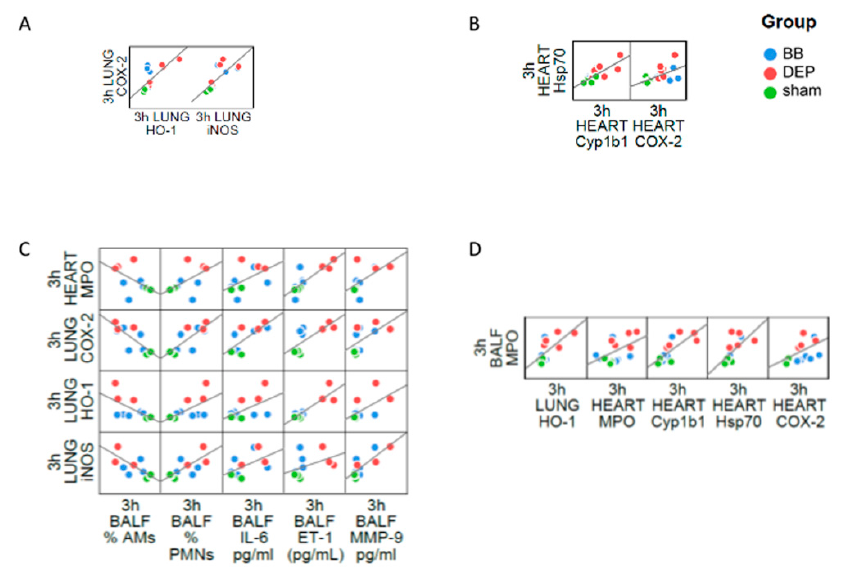
Figure 7. Correlation analysis between inflammation and oxidative stress in acute treatment. Dispersion plot showing the co-distribution of markers intra-lung ( A ), intra-heart ( B ), inter-lung / heart and BALf ( C , D ). Linear regression correlations are displayed as black lines.